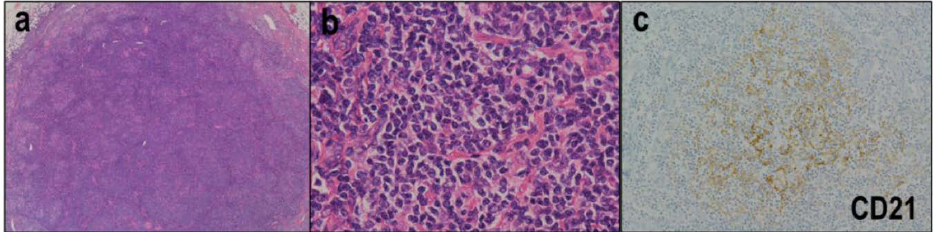
Figure 4. Follicular T-cell lymphoma. ( a ) Lymph nodes show a nodular/follicular growth pattern (HE 40). ( b ) Aggregations of intermediate-sized neoplastic cells with round nuclei and pale × cytoplasm are recognized inside the follicles (HE the FDC meshworks in nodular/follicular structures (HE